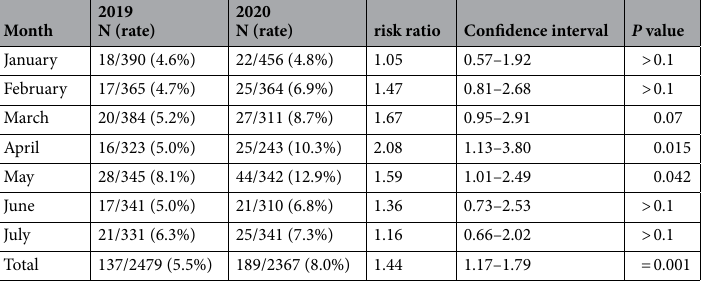
Table 1. Risk Ratio of new-onset psychoses or mania by month in 2019 and 2020.